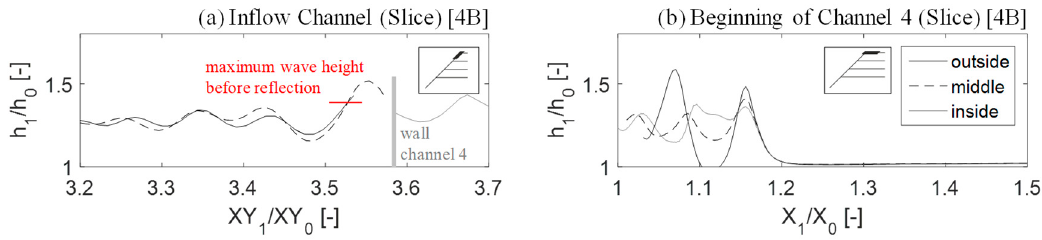
Figure 6. Slice of the inflow channel ( a ) and channel 4 ( b ) at the outside, middle and inside, for the time step 4.5 s.